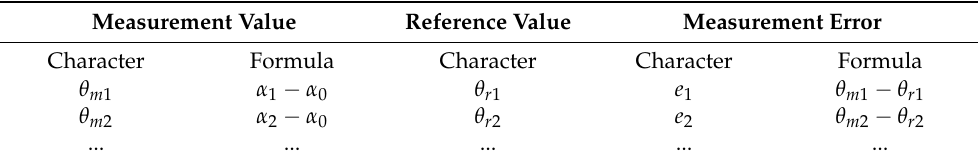
Table 2. Correlation of the parameters.